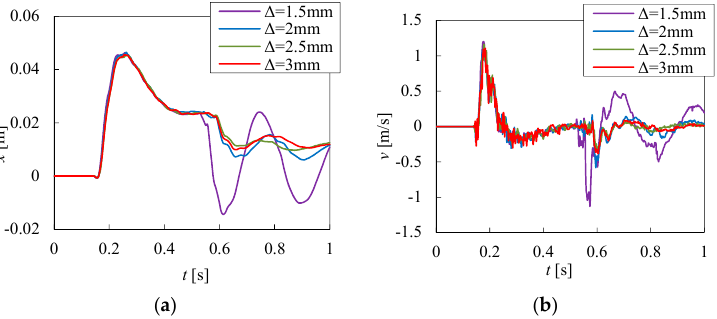
Figure 3. Comparison of ( a ) horizontal displacement and ( b ) horizontal velocity at the top of the structure using different initial particle spacings.